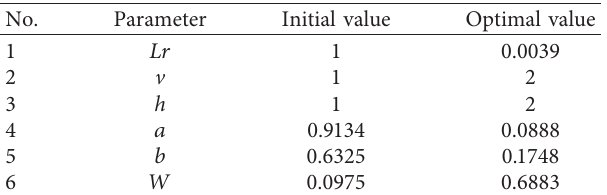
Figure 9: The optimization process of WOA. Table 3: Simulation